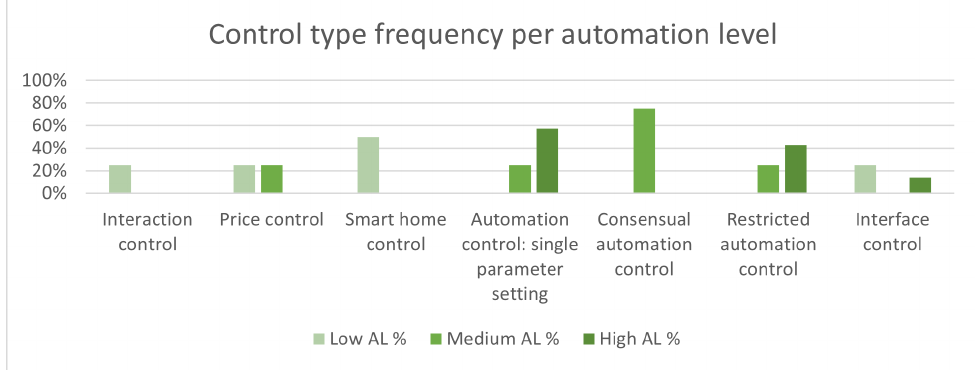
Figure 5. Control per automation level.